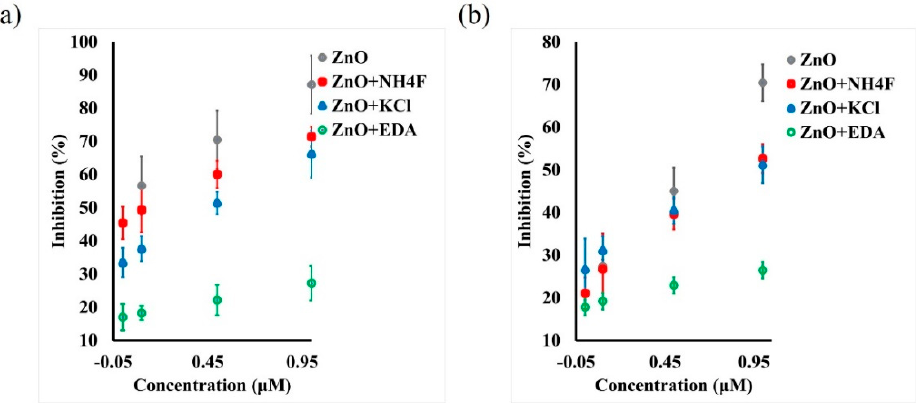
Figure 8. Calibration curve showing paraoxon concentration and percent AChE inhibition on ( a ) carbon paper and ( b ) carbon cloth